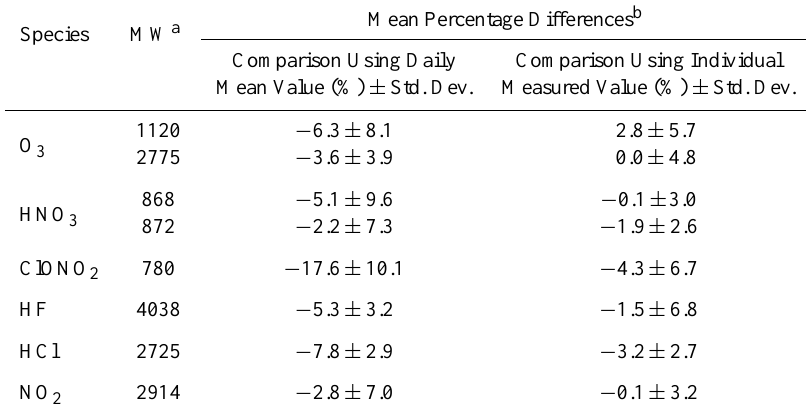
Table 3. Comparisons of total columns observed by the DA8 FTS and PARIS-IR from 21 February to 8 March 2006. Mean Percentage Differences b Species MW a Comparison Using Daily Comparison Using Individual Mean Value (%) ± Std. Dev. Measured Value (%) ± Std. Dev. 1120 − 6.3 ± O 3